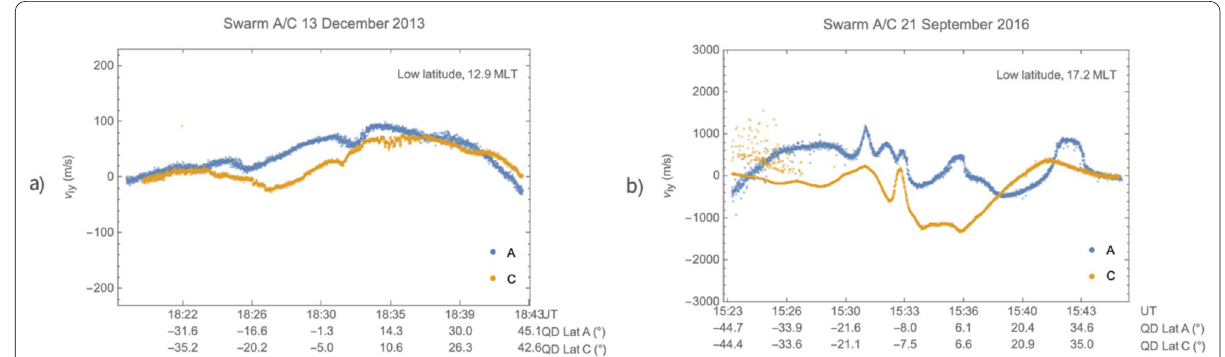
Fig. 14 Examples of unexpected low-latitude cross-track horizontal ion drift from Swarm A and C at two epochs of the mission. Each time series is centered at the magnetic